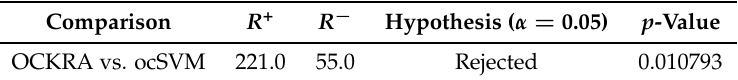
Table 9. Wilcoxon signed-ranks test comparison between AUC obtained respectively by ocSVM and OCKRA classifiers when using the DS-1 dataset.